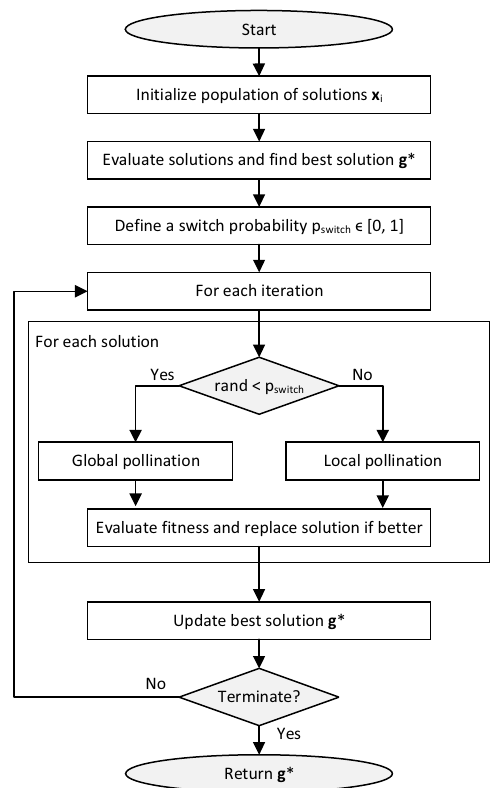
Fig. 4. Flowchart of the Flower Pollination Algorithm (FPA)